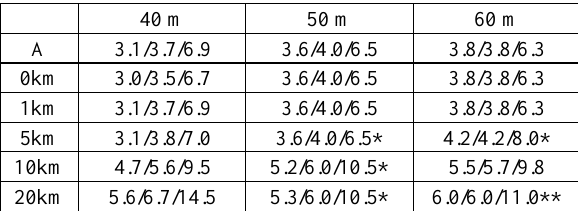
Table 3. Estimated standard deviation of position accuracy (E/N/U) [mm] as reported by Waypoint Inertial Explorer for each flying height and baseline distance. One asterisk (*) indicates an atypical range of variability in the estimated standard deviation; two asterisks (**) indicates a much greater range of variation, caused by a loss of fixed ambiguity. The held position of each static base receiver was solved using 0.020 – 0.023